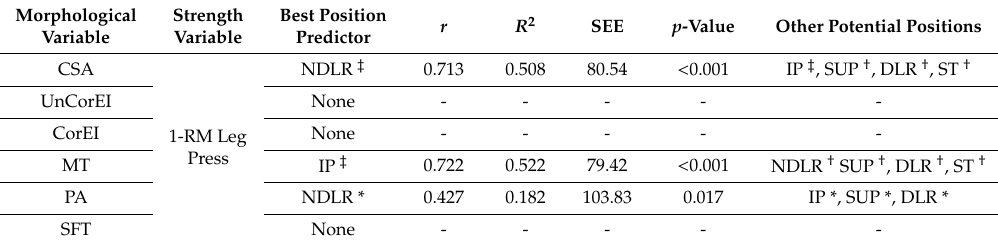
Associations between ultrasound-derived morphological characteristics and maximal unilateral strength based on the rest position having the greatest shared variance with the dependent variable. The morphological variable is presented first, followed by the rest position that best predicts the dependent variable. “None” indicates that the specific measure of morphology was not a significant predictor of maximal strength after rest in any position. “Other Potential Positions” denotes rest positions also having a significant association with the dependent variable. r : Pearson’s correlation coe ffi cient; R 2 : Shared variance; SEE: Standard error of the estimate;